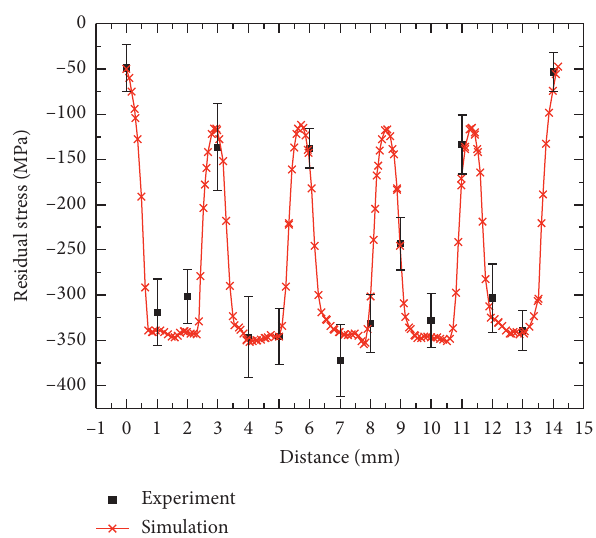
Figure 20: Residual stress distribution curves of material